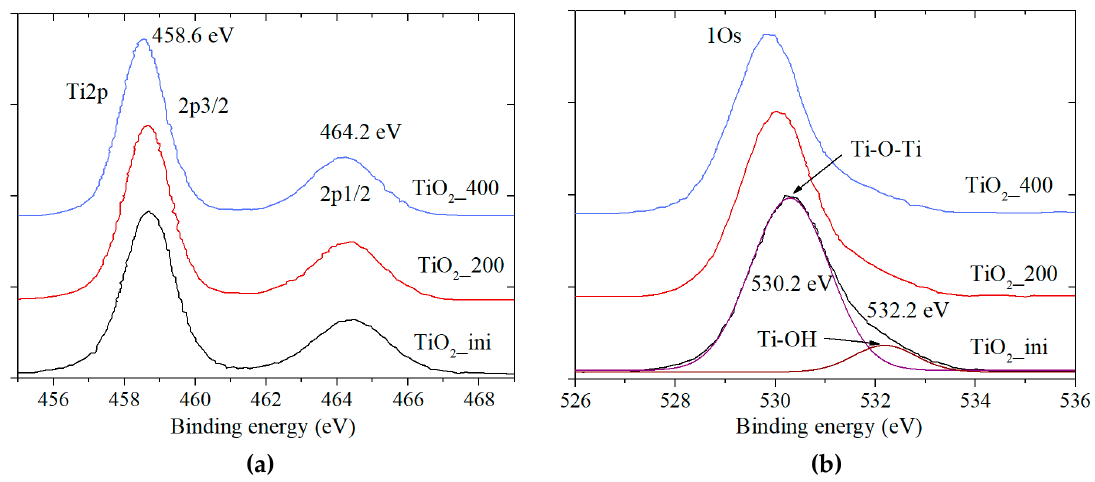
Figure 5. XPS data for the ( a ) Ti 2p and ( b ) O 1s spectra.